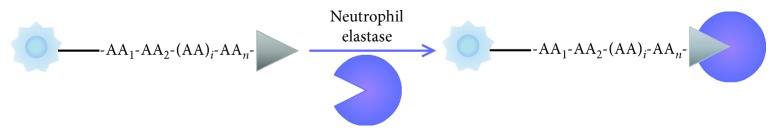
Overall principle of activity-based probe (ABP). Warhead (grey triangle) structurally matches with the target protease (purple). Active ABP can be detected by the tag (blue star). AA1-AAn indicates amino acid position in the specific peptide.